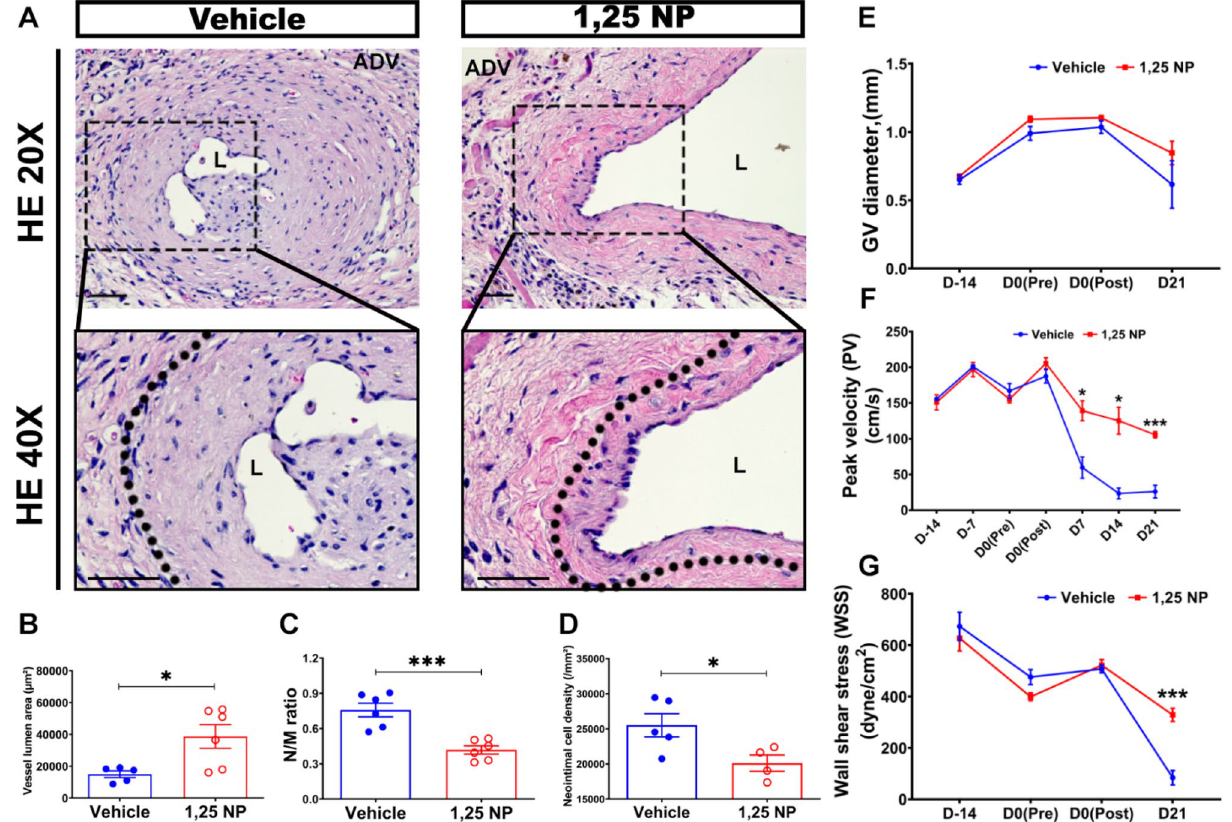
Figure 3. Murine outcomes in 1,25 NP treated vessels. ( A ) Representative H and E sections from vehicle and 1,25 NP treated AVFs at day 21, respectively. In 1,25 NP AVFs compared to vehicle controls, there was significant increase in the average lumen vessel area ( B ), but decrease in N/MA ratio ( C ) and neointimal cell density ( D ). There was increase in the average outflow venous diameter in 1,25 NP group mice ( E ). At day 21 after PTA plus 1,25 NP delivery, there was a significant increase in the average peak velocity ( F ) and wall shear stress ( G ) compared to controls. Each time point represents the mean ± SEM of 5–6 animals. Two-way ANOVA with Bonferroni’s correction was performed in ( E – G ). ( B – D ) were performed with unpaired t test. Significant differences between vehicle and 1,25 NP treated vessels are indicated * p < 0.05, ** p < 0.01. N/M neointima area/ media area; ADV adventitia, L lumen. Scale bar is 50